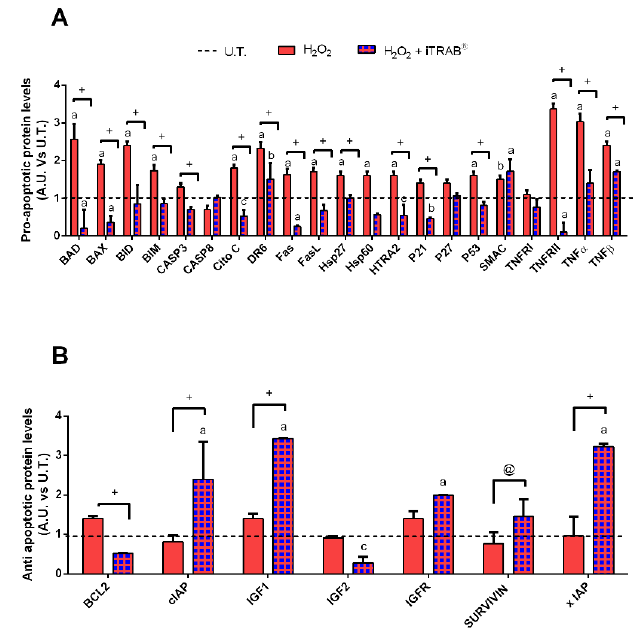
Figure 2. Apoptosis Array.Analysis of pro- and anti- apoptotic protein levels ( A , B , respectively) in 3D-HTMCs, cultured under dynamic conditions, were performed both after the 2nd exposure of only 500 µM H 2 O 2 and co-treatment with iTRAB and 500 µM H 2 O 2 ,by Human Antibody Array C1 (RayBio C-series). The black dotted line represents the protein level of untreated (U.T.) 3D human trabecular meshwork cells (HTMCs) for each protein examined. The anti-apoptotic pattern represents only the data related to those proteins that showed significant different levels compared to U.T. and H 2 O 2 -treated. Three separate conditions were arrayed and for each experiment, the intensity of Positive Control Spot was used to normalize signal responses for a comparison of results across multiple arrays . a, b, c, treated 3D HTMCs vs. UT; @, + H 2 O 2 -treated vs. H 2 O 2 +iTRAB-treated 3D HTMC. a/+ p < 0.001; b p < 0.01; c/@ p < 0.05 (Two-way ANOVA followed by Bonferroni’s test).